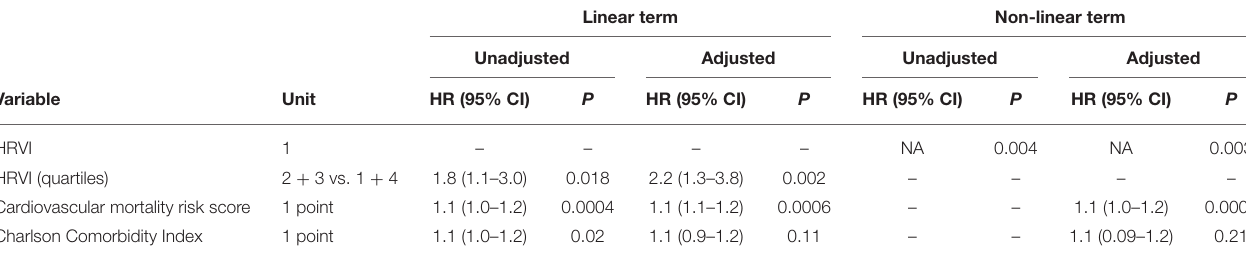
TABLE 4 | Linear and non-linear associations of risk variables with all-cause mortality in unadjusted and adjusted Cox regression analysis.